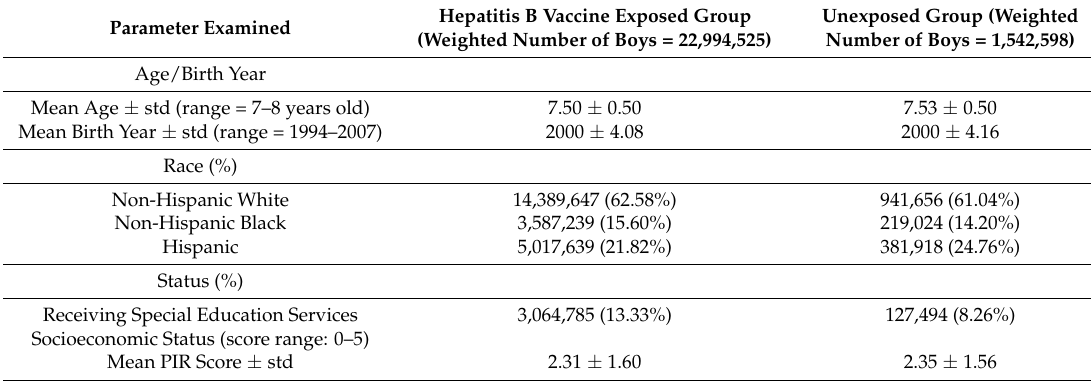
Table 1. Characteristics of the boys born between 1994 and 2007 (weighted number of boys = 24,537,123) examined in this